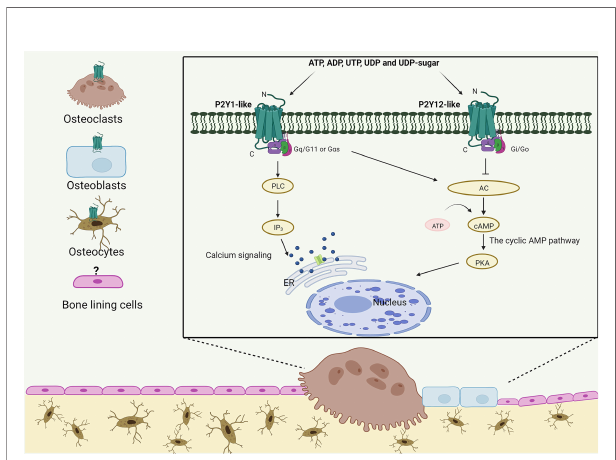
FIGURE 1 | The structure and signaling pathway of P2YRs in bone. P2Y1-like and P2Y12-like receptors are expressed in most types of bone cells (expression status of P2YRs in bone lining cells is current unknown) and are activated by extracellular nucleotides present in the microenvironment. The topological characteristics of P2YRs are: an extracellular N-terminus and an intracellular C- terminus; seven transmembrane domains forming the ligand docking pocket; the C-terminus has the protein kinases binding motif and in fl uence the degree of P2Y subtypes coupling with Gq/G11, G a s and Gi/Go proteins via intracellular loop structural diversity. Binding of different G proteins leads to downstream signaling cascades including calcium signaling transduction and regulation of AC/cAMP pathway (Figure was created with